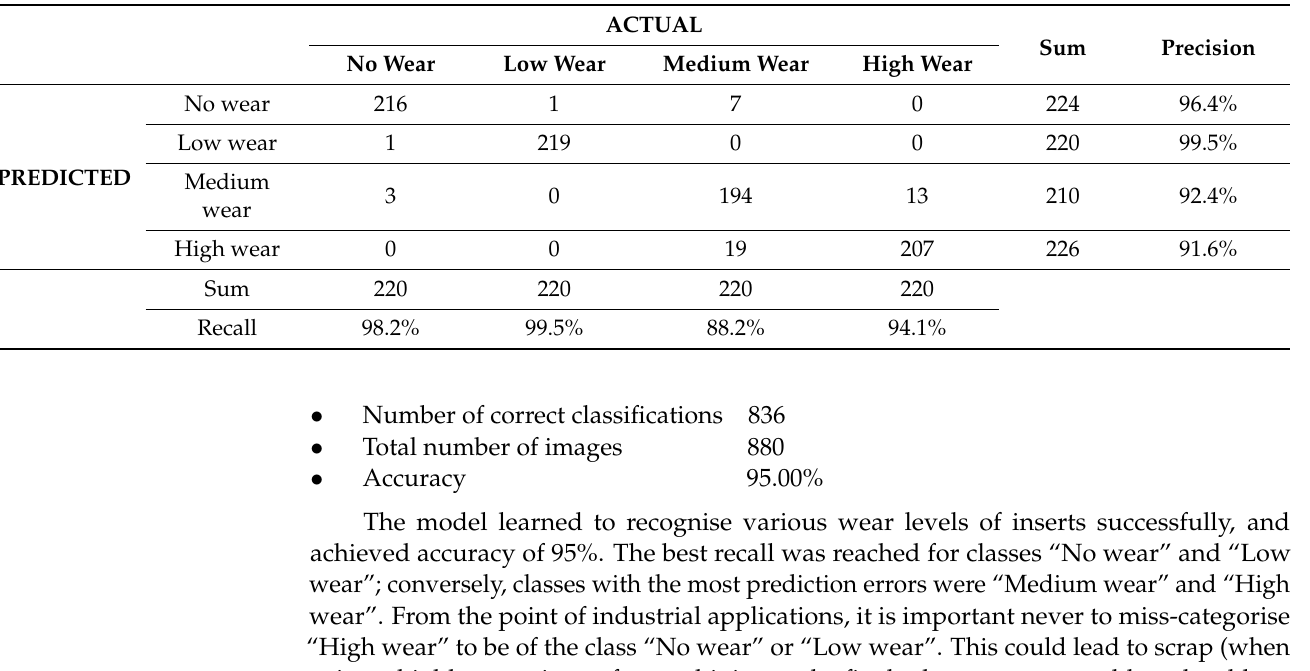
Table 8. Confusion matrix for the tool wear